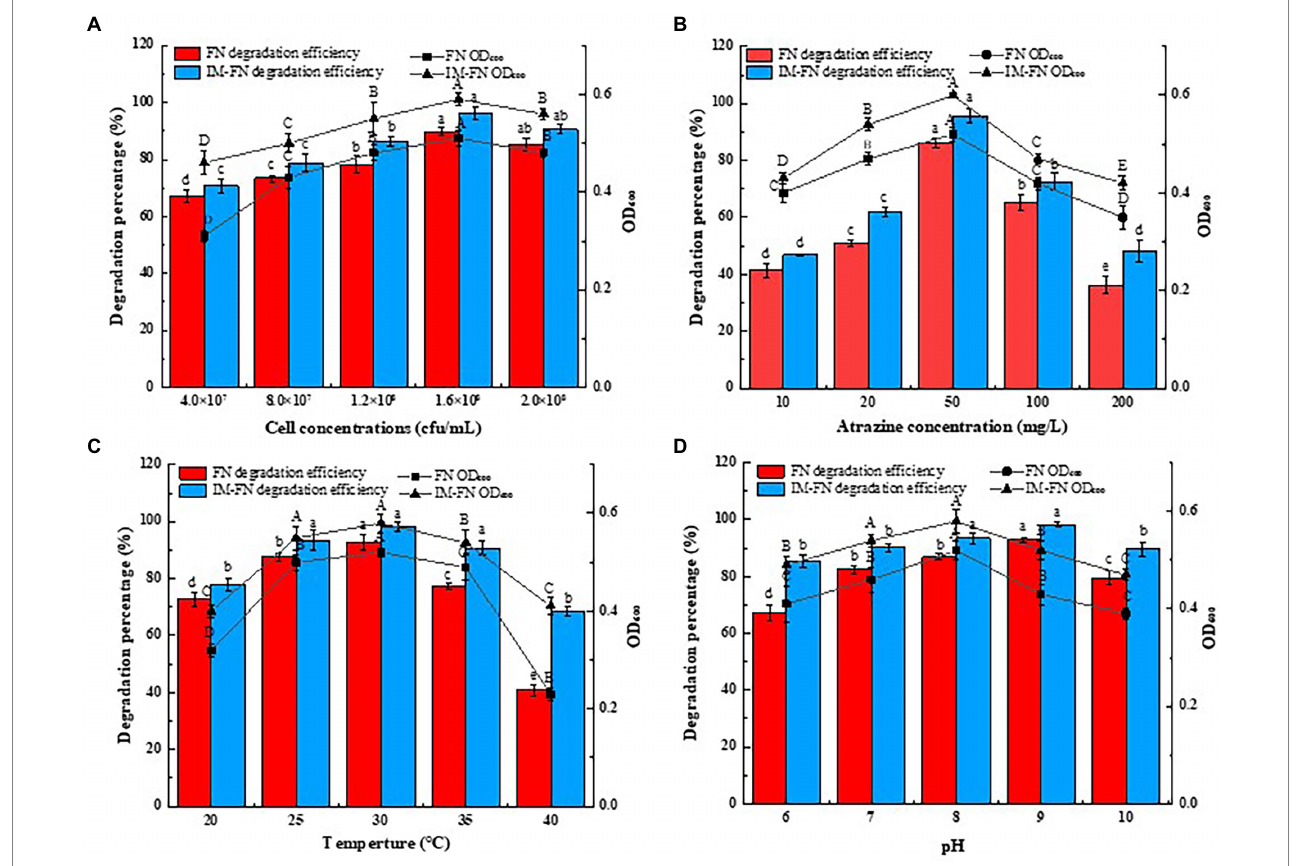
FIGURE 5 Effects of culture conditions, i.e., bacteria concentration (A) , atrazine concentration (B) , temperature (C) , and pH level (D) on degradation of atrazine by bacterial suspensions (FN) and immobilized bacterial mixture (IM-FN). The lowercase letters above the bars indicate significant differences between different treatments at the level of p < 0.05; the uppercase letters indicate significant differences between different treatments at the level of p < 0.01. Error bars represent standard deviation of triplicate samples.